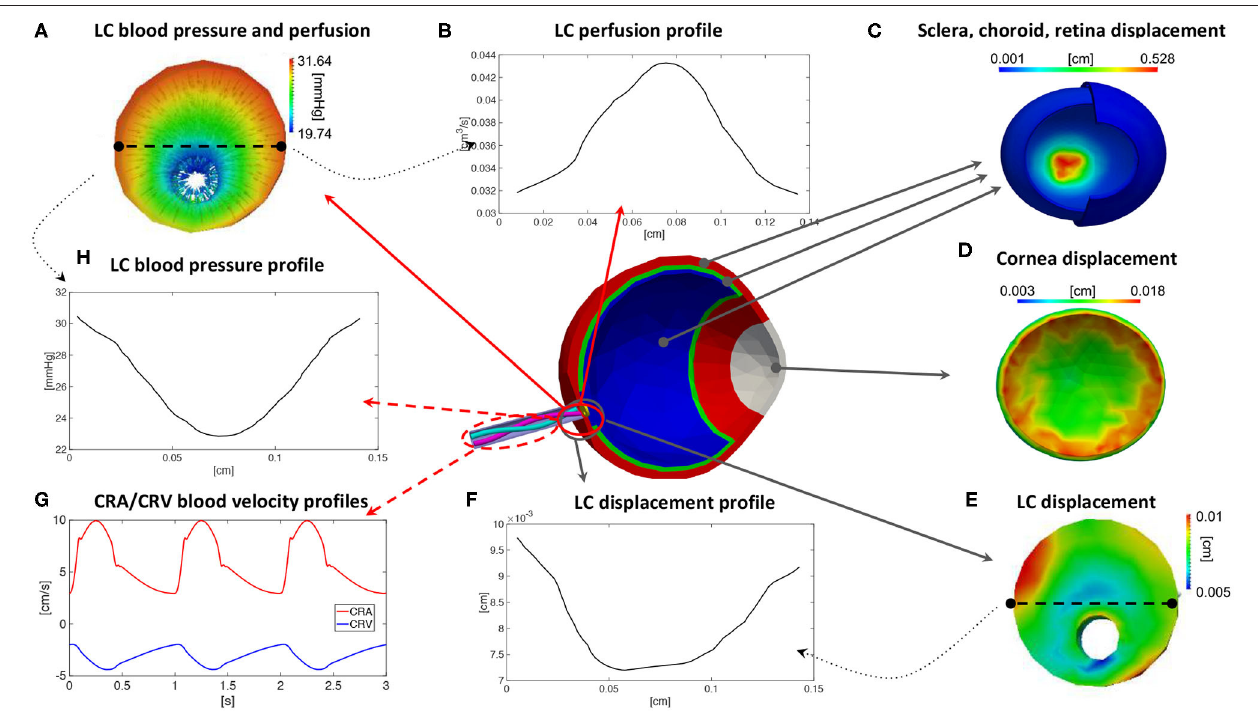
FIGURE 3 | Illustrative schematic of the outputs that can be predicted by means of the Ocular Mathematical Virtual Simulator (OMVS) (Sala, 2019). The outputs include: quantitative three-dimensional colormaps of pressure, perfusion, and displacement fields in the lamina cribrosa (A,E) , with the possibility of plotting profiles along specific sections or lines (B,F,H) ; quantitative three-dimensional colormaps of distributions of displacement in the ocular tissues (C,D) ; time-dependent velocity waveforms in the central artery and vein (G) . LC, lamina cribrosa; CRA, central retinal artery; CRV, central retinal vein.